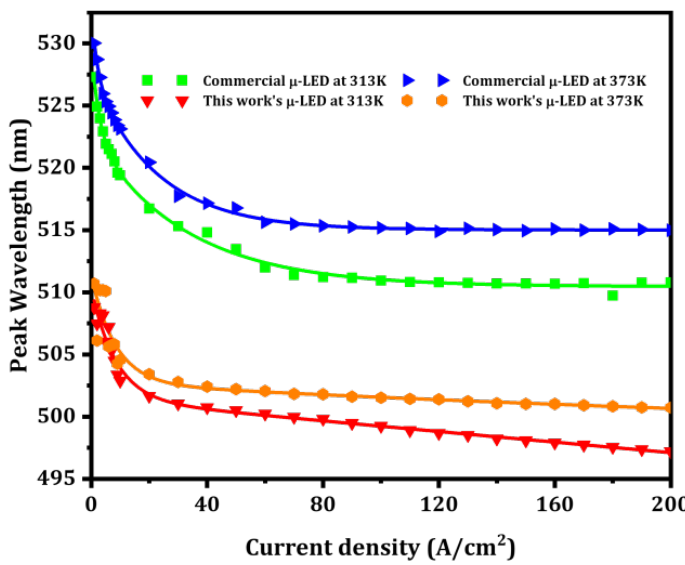
Figure 3. Measured temperature-dependent wavelength as a function of current density.